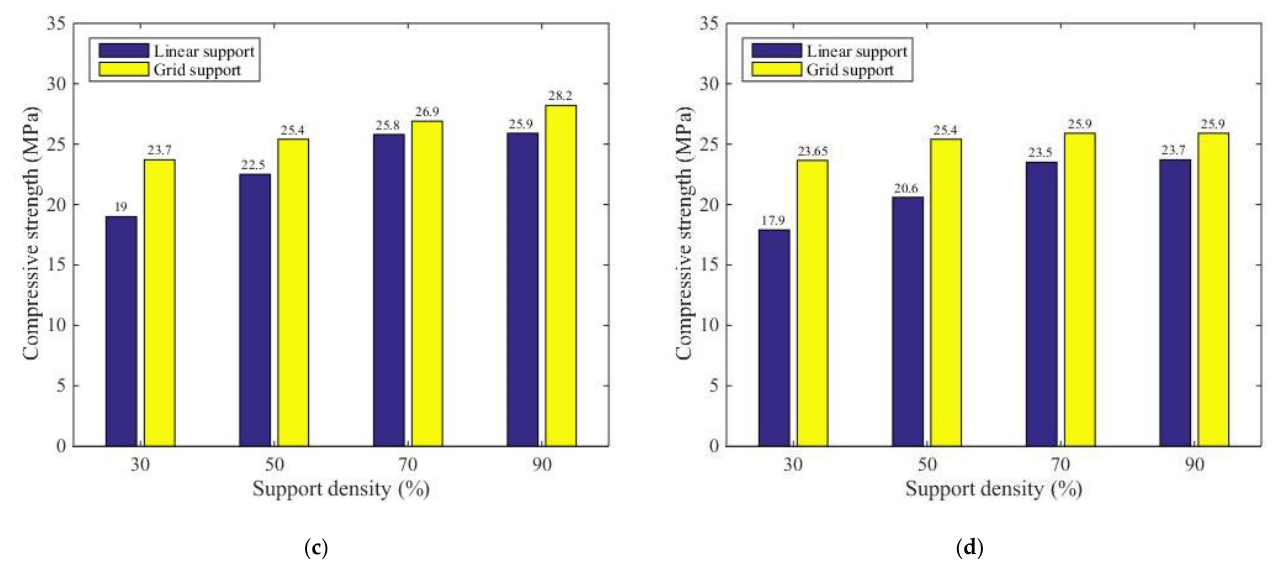
Figure 14. Compressive strength of the two support models with the same Z directional support distance model and different support densities: ( a ) support and model surface and distance Z = 0.08 ; ( b ) support and model surface and distance Z = 0.10; ( c ) support and model surface and distance Z = 0.12 ; ( d ) support and model surface and distance Z = 0.14.